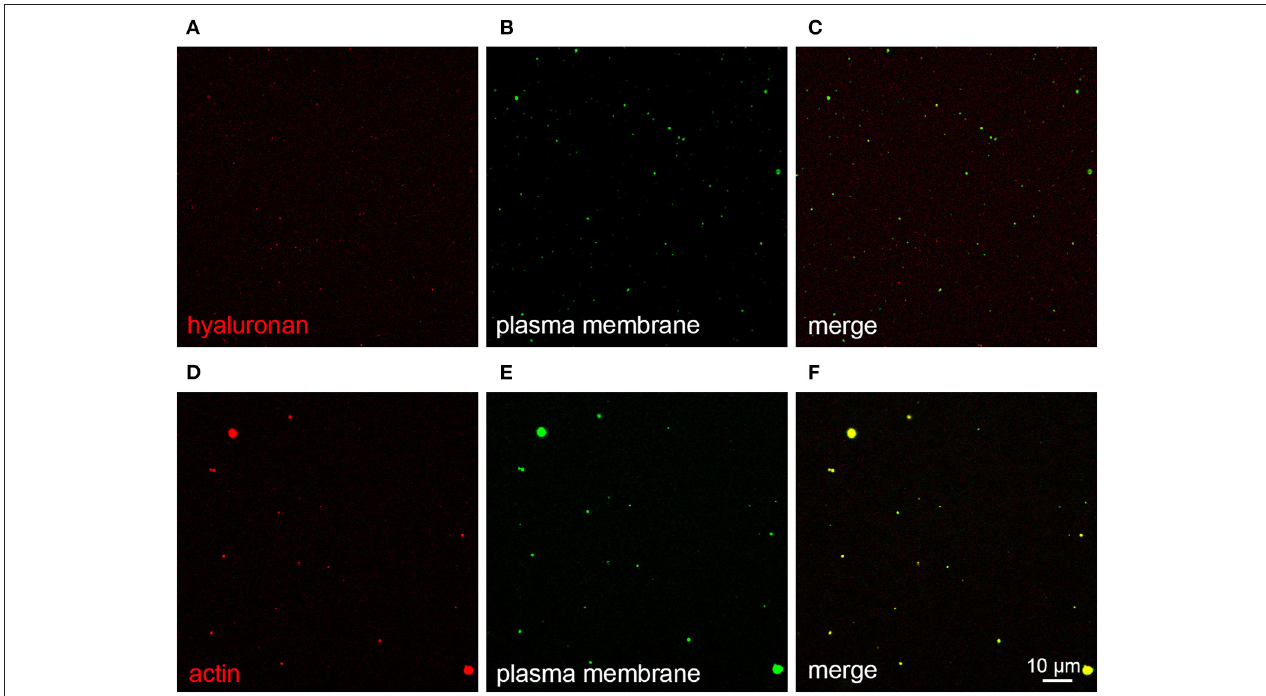
FIGURE 4 | Extracellular vesicles (EVs) from bronchoalveolar lavage fluid (BALF) stained with CellMask Deep Red plasma membrane stain (pseudocolored green, B,E ), combined with Alexa Fluor 568-labeled hyaluronan binding complex (A) or 594-labeled phalloidin to detect F-actin (D) , both pseudocolored red. Merged images are shown in C,F , respectively. EVs in panels A–C were isolated by size-exclusion chromatography from BALF of a control horse. EVs in D–F were obtained by centrifugation and concentration of BALF of an asthmatic horse.